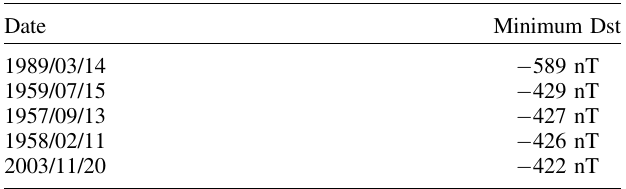
Table 1. Top fi ve magnetic storms with the most negative Dst index since